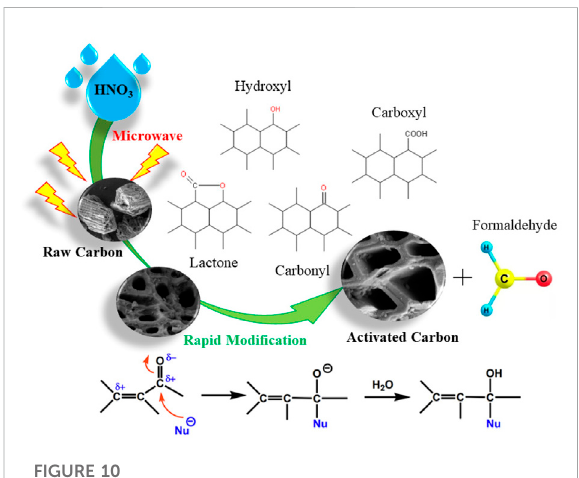
FIGURE 10 Formaldehyde adsorption reaction mechanism of HNO 3 coupled microwave rapidly modi fi ed